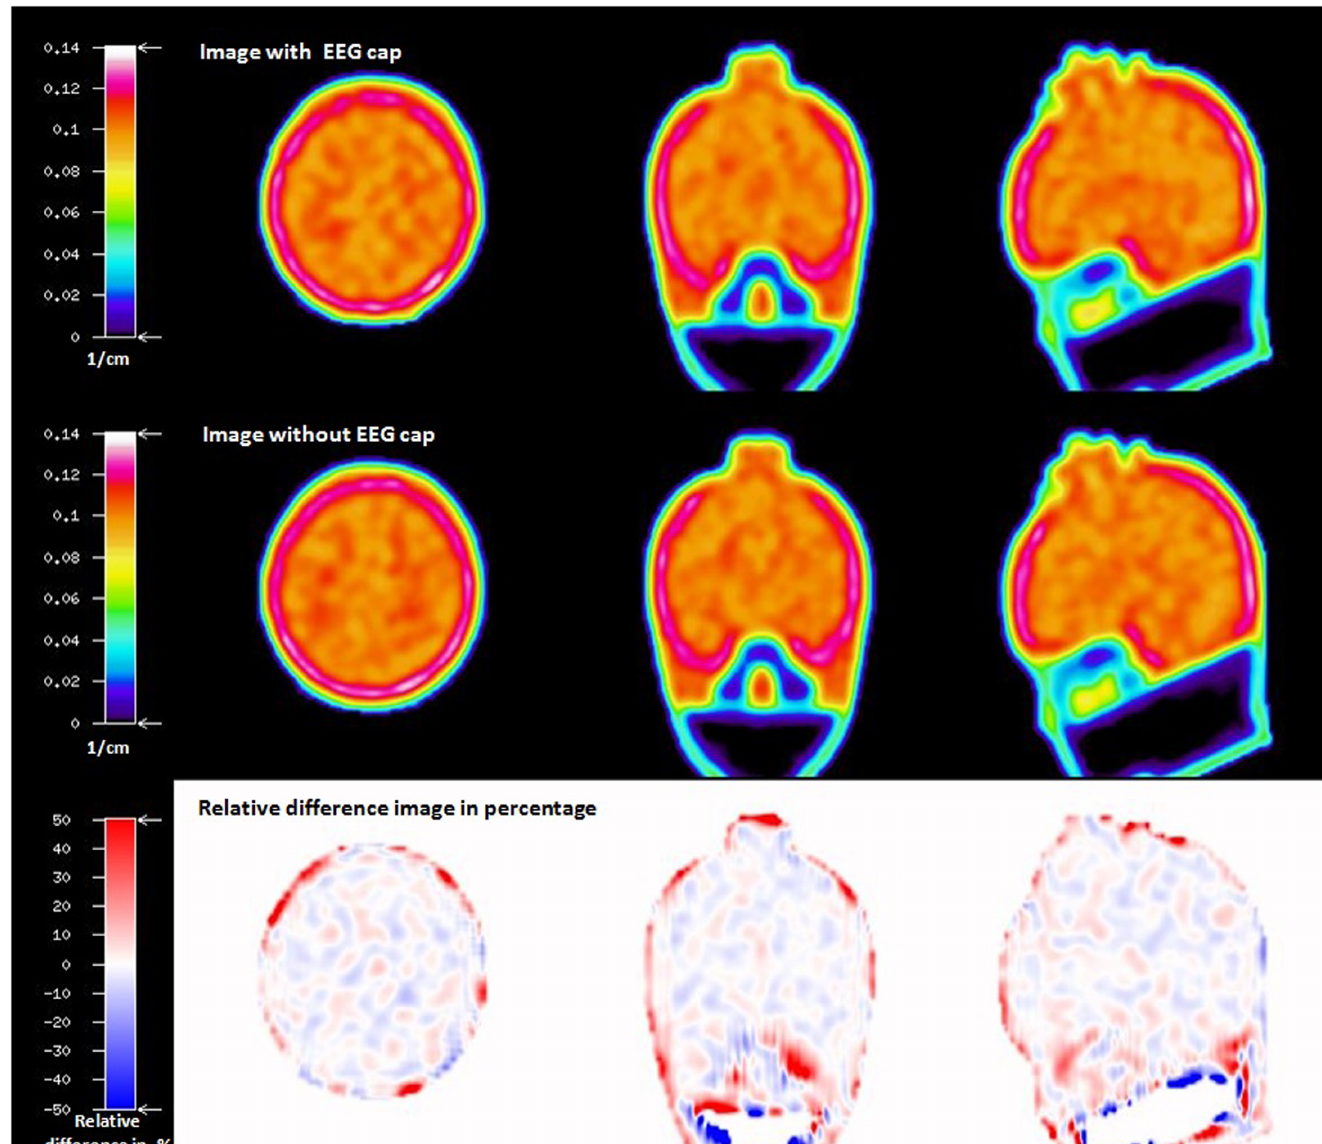
Fig 3. Attenuation maps of the Iida phantom with EEG cap (AMw, upper row) and without EEG cap (AMwo, middle row); relative difference image in percentage (bottom row).